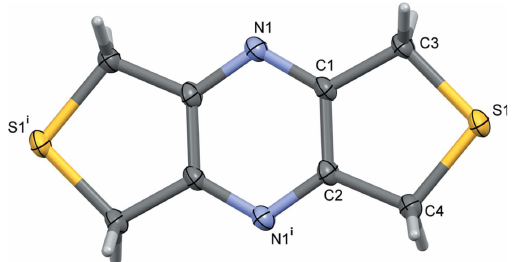
Figure 2 The molecular structure of L2 , with atom labelling; symmetry code: (i) (cid:4) x + 3 , (cid:4) y + 1 , (cid:4) z + 1]. Displacement ellipsoids are drawn at the 30% 2 2 probability